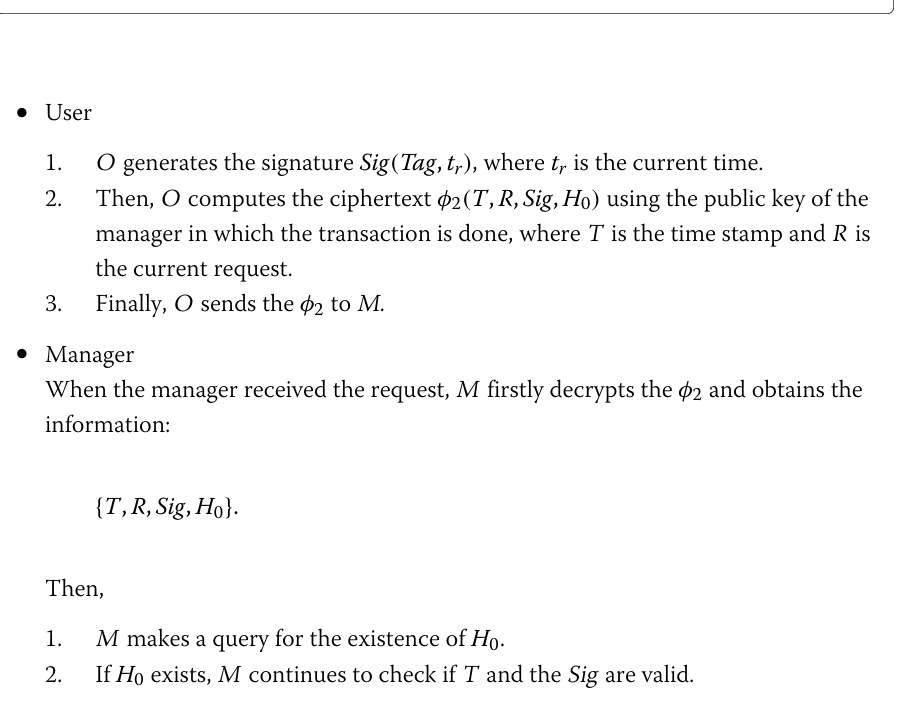
Fig. 5 The authentication of user. The regional manager completes the user’s identity authentication through a series of